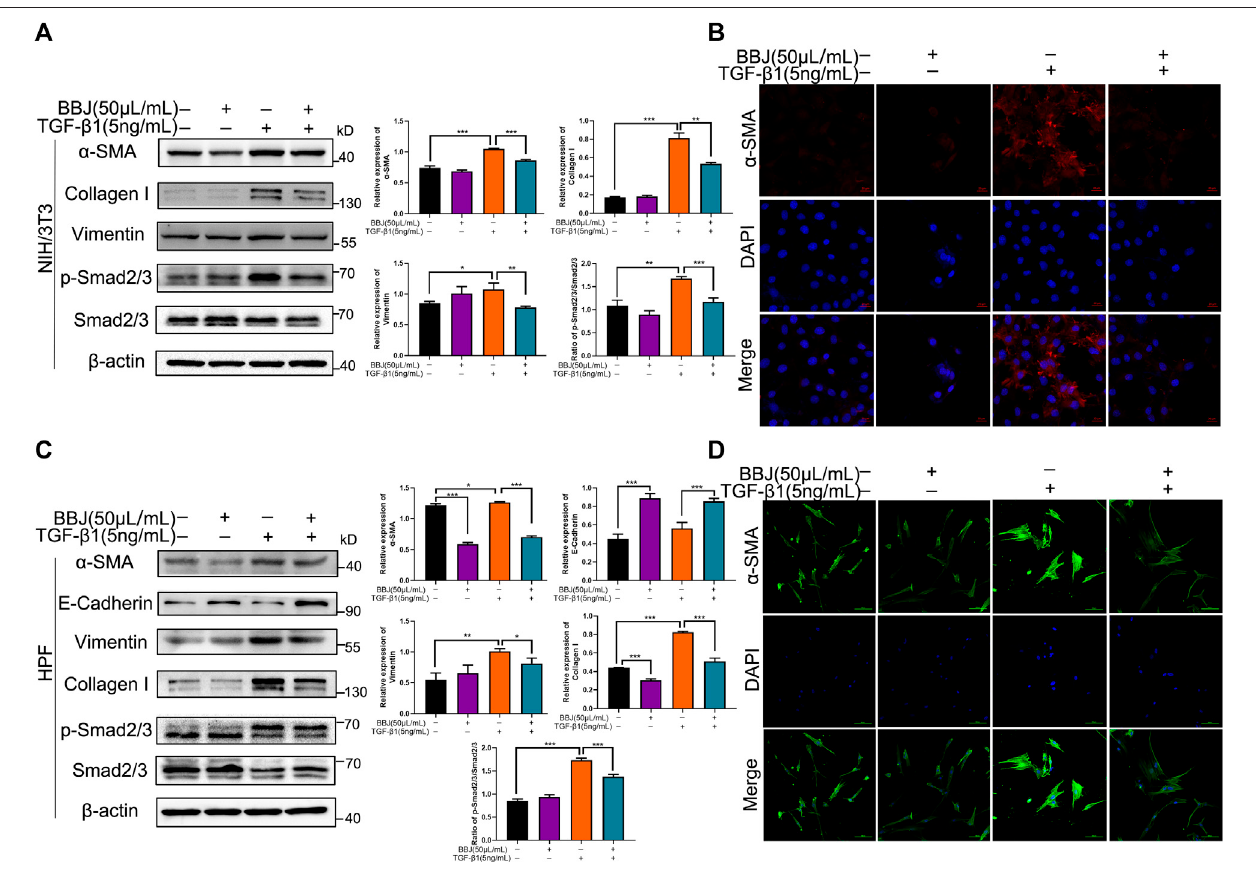
FIGURE2| BBJrestrainedactivationanddifferentiationofNIH/3T3andHPFinducedbyTGF- β 1.NIH/3T3orHPFwasplanted,starvedfor6 h,stimulatedby5 ng/ mlTGF- β 1for1 h,andthenincubatedwith50 μ l/mlBBJforanextra24 h. (A) Expressionsof α -SMA,vimentin,collagen-I,Smad2/3,p-Smad2/3,and β -actininNIH/3T3 were presented by western blotting. (B) The expression of α -SMA in NIH/3T3 was visualized by a confocal microscope (×40). (C) Expressions of α -SMA, E-cadherin, vimentin, collagen-I, Smad2/3, p-Smad2/3, and β -actin in HPF were tested by western blotting. (D) The expression of α -SMA in HPF was visualized by a confocal microscope (×40). * p < 0.05; ** p < 0.01; *** p < 0.001 versus the control group or the TGF- β 1